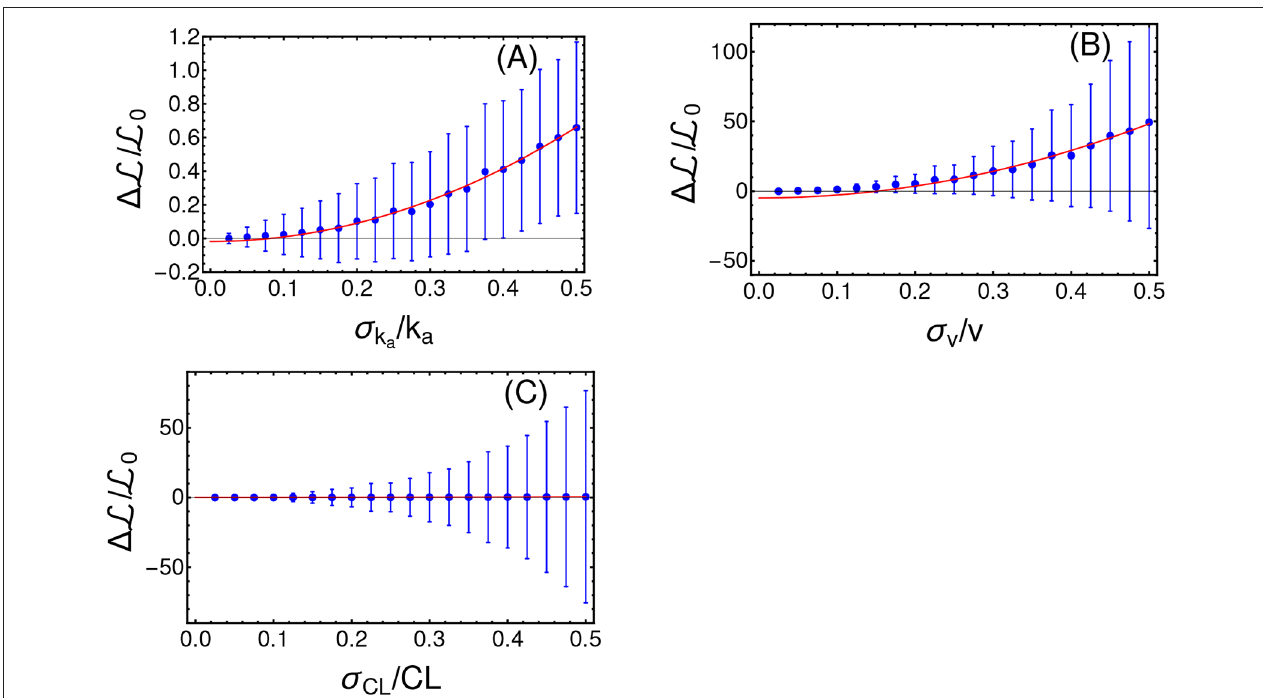
FIGURE 7 | Robustness analysis with respect to intra-patient variability. Intra-patient variability is here defined as stochastic noise randomly picked in the uniform distribution χ r = [ − σ r , σ r ] and applied to distinct PK parameters. In particular, we here show the average and the standard deviation of the relative variation of the cost 1 L / L 0 , with respect to distinct levels of noise, in the cases: r = k a (A) , r = v in (B) , and r = CL (C) . Values of the fit are provided in Table S5 .